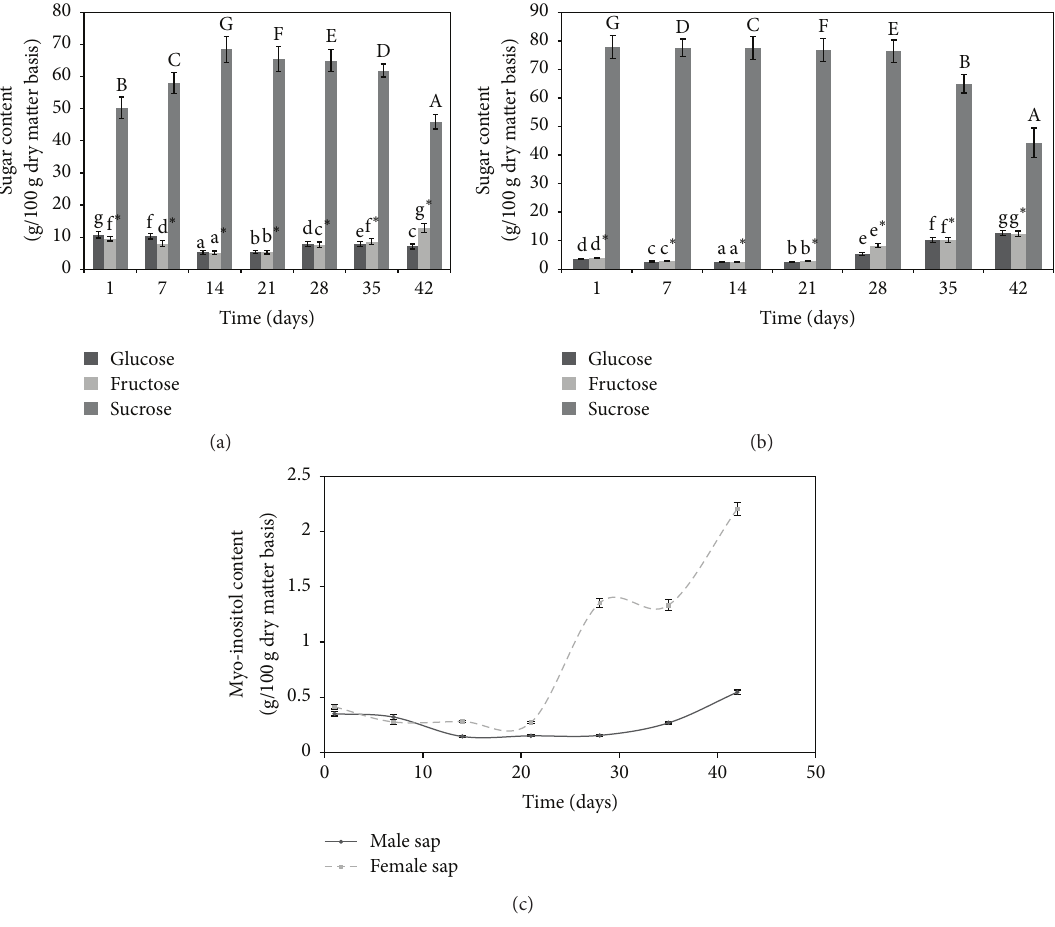
Figure 3: Variation of sugar contents of male and female date palm sap according to the collection time. (a) Variation of glucose, fructose, and sucrose contents in male date palm sap according to the collection time. (b) Variation of glucose, fructose, and sucrose contents in female date palm sap according to the collection time. (c) Variation of myo-inositol content in male and female date palm sap according to the collection time. (a) Means with different small letters are significantly different ( 𝑝 < 0.05 ). Means with different capital letters are significantly different ( 𝑝 < 0.05 ). (b) Means with different small letters are significantly different ( 𝑝 < 0.05 ). Means with different capital letters are significantly different ( 𝑝 < 0.05